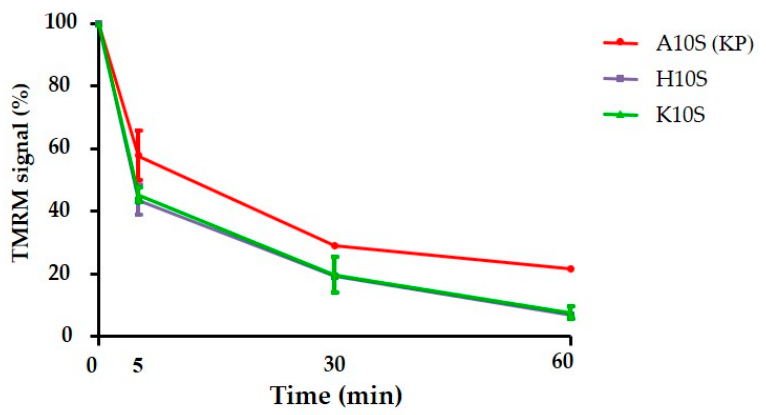
Figure 11. Change in TMRM fluorescence intensity in Candida albicans SC5314 cells after peptide treatment. Data represent the mean ± standard deviation from three independent experiments.